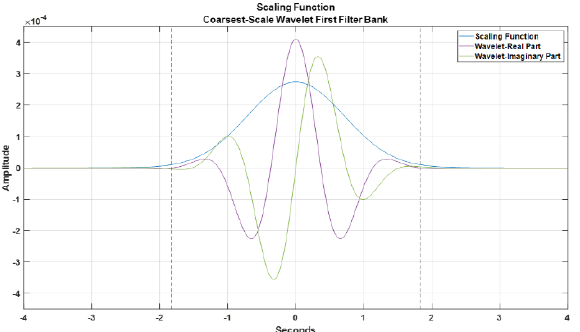
Figure 17. Scaling function and the coarsest-scale wavelet plot for the wavelet scattering network.